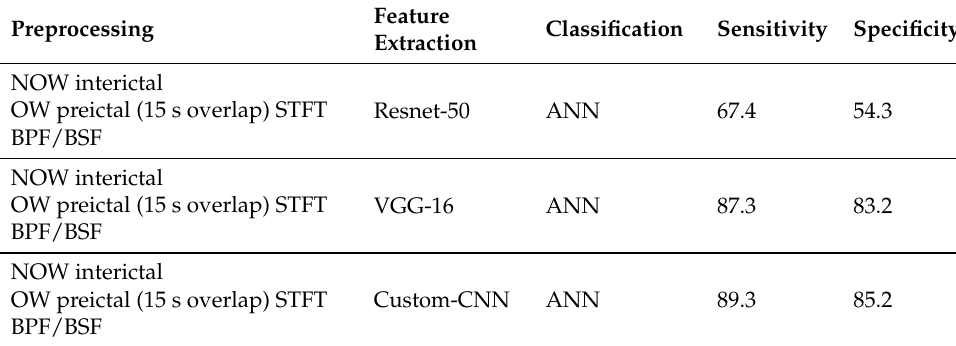
Table 4. Results of various feature extraction techniques used in the proposed system.